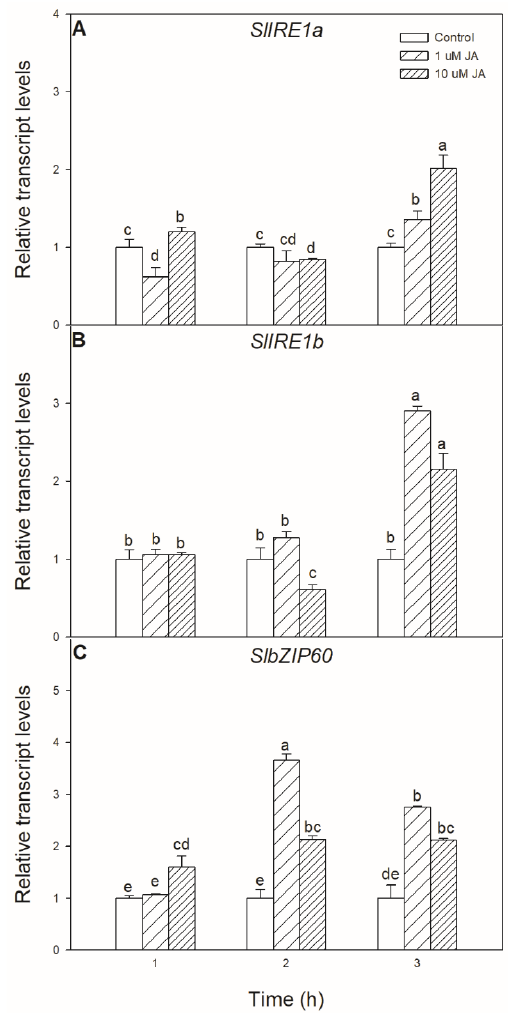
Figure 2. Changes in the transcript accumulation of SlIRE1a ( A ), SlIRE1b ( B ), and SlbZIP60 ( C ) in the leaves of wild-type tomato plants exposed to 1 or 10 µ M jasmonic acid (JA) for 6 h. Results are the means ± SE. Data with di ff erent letters indicate significant di ff erences at p < 0.05 level, n = 3.